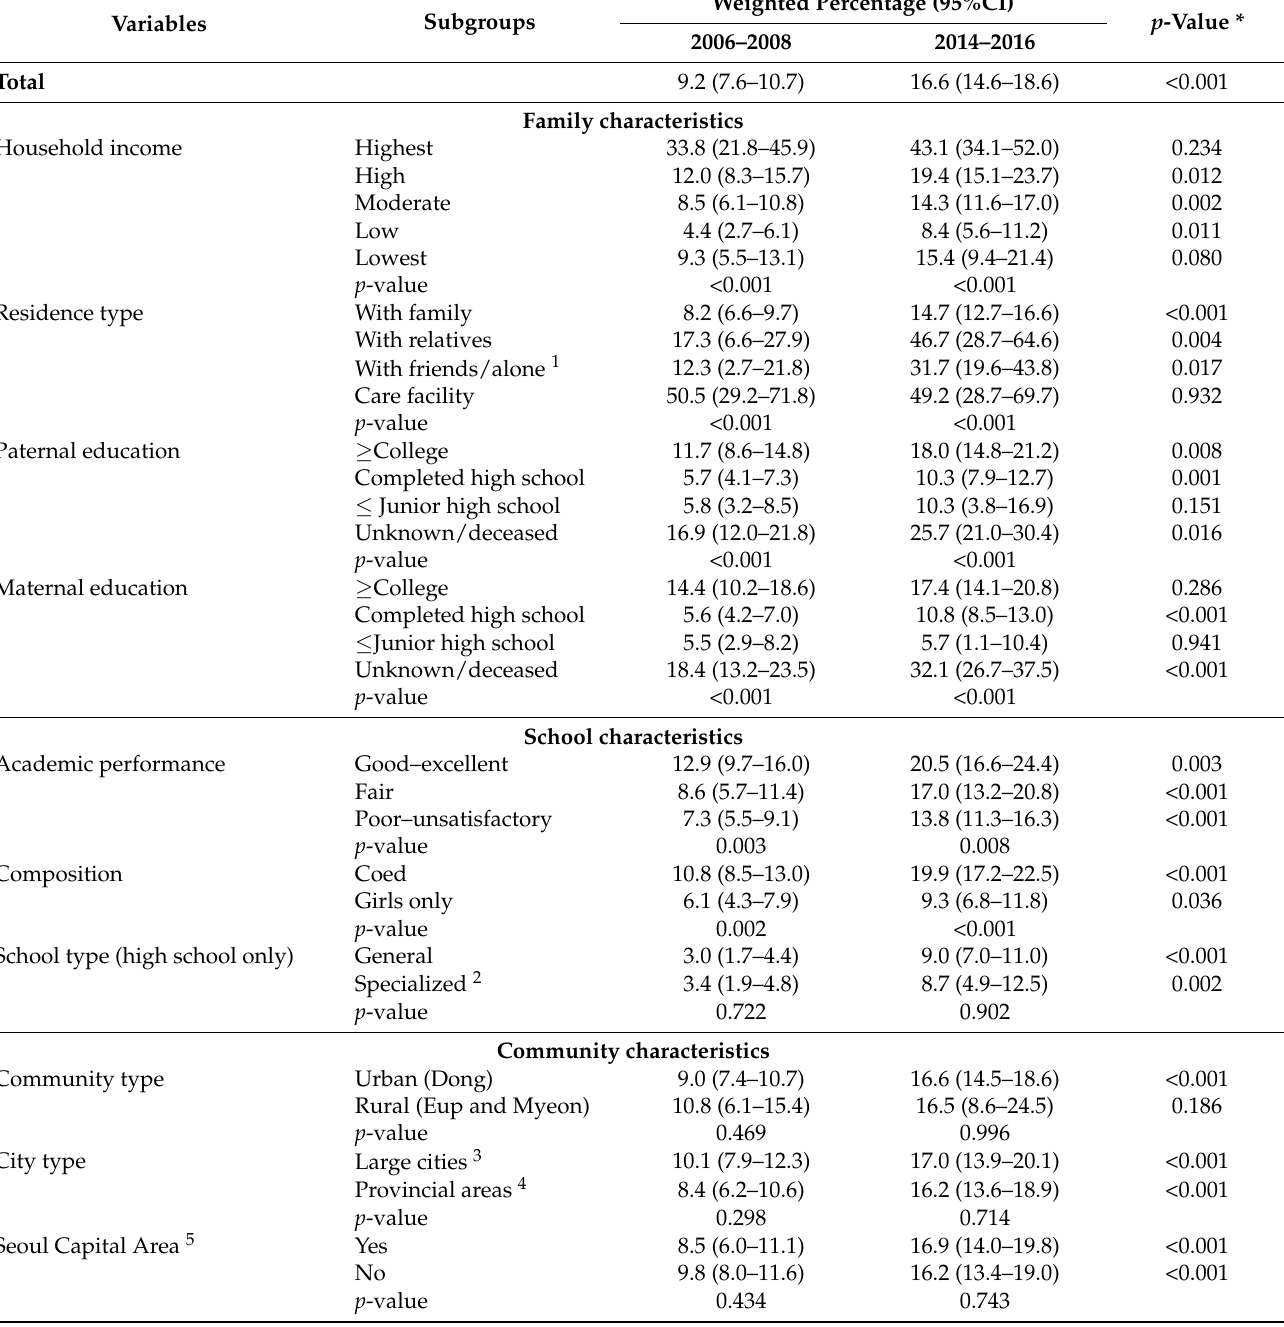
Table 3. Weighted percentage of girls reporting early sexual